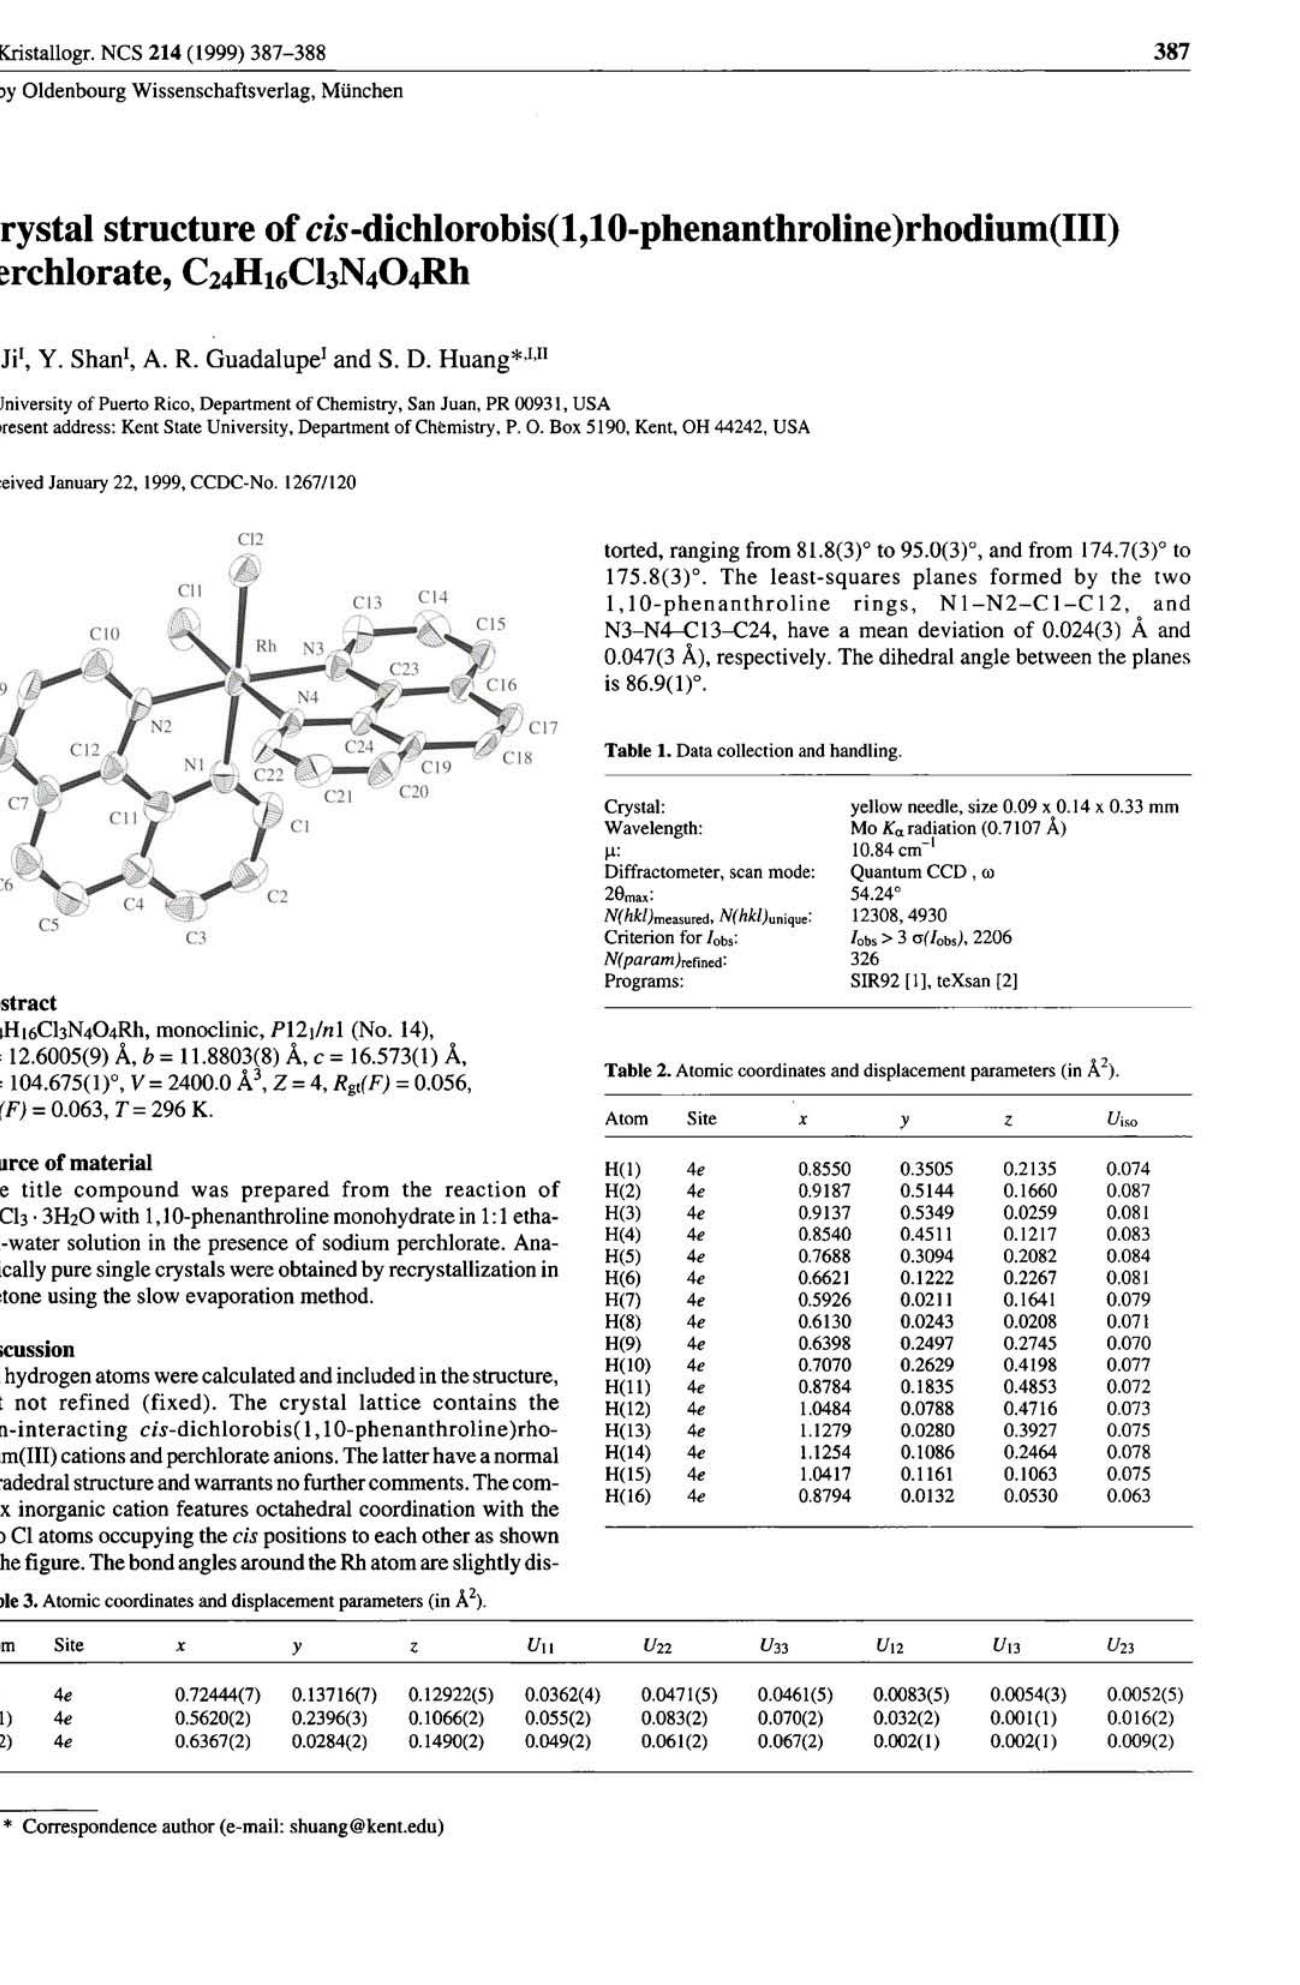
Table 1. Data collection and handling.